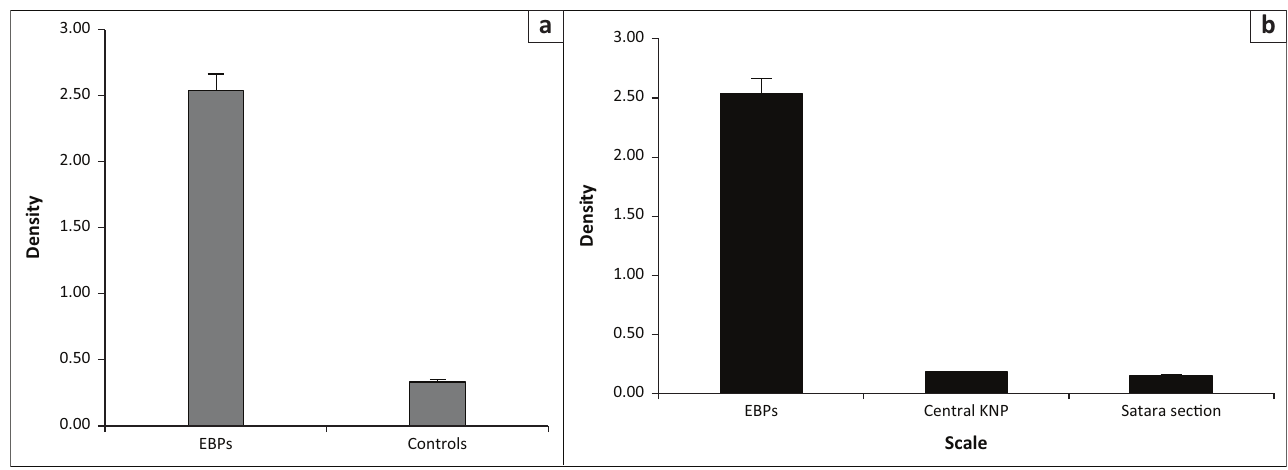
FIGURE 2: (a) Overall herbivore density estimates, on the experimental burn strings (N’Wanetsi, Satara and Marheya) of Satara, Kruger National Park, and (b) herbivore density estimates across fire treatments per burn string (95 % confidence interval shown).